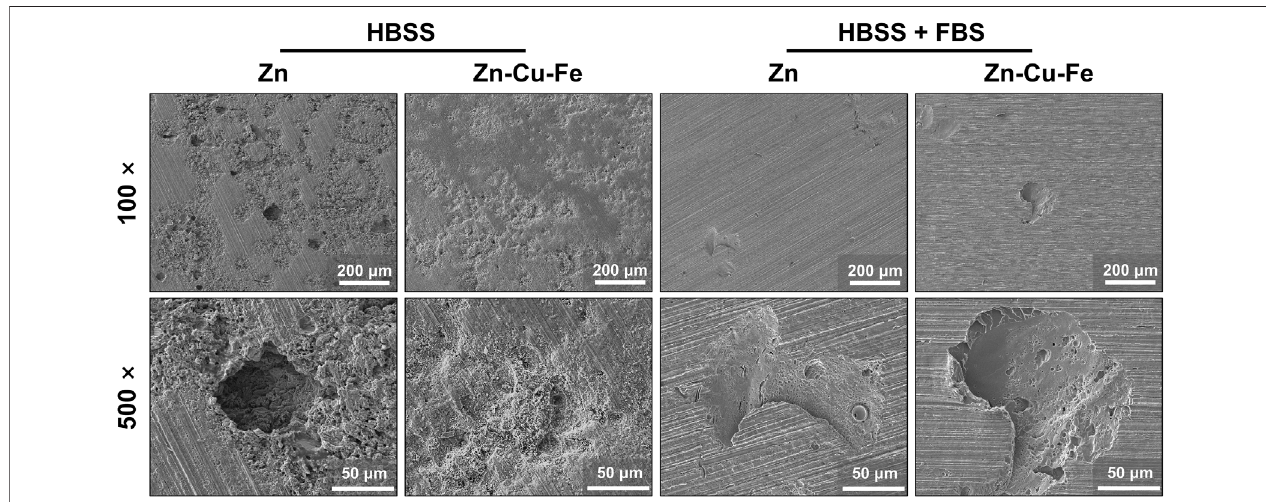
FIGURE 4 | Representative SEM images of pure Zn and Zn-Cu-Fe alloy after removing degradation products (low magni fi cation: 100 × and high magni fi cation: 500 ×).